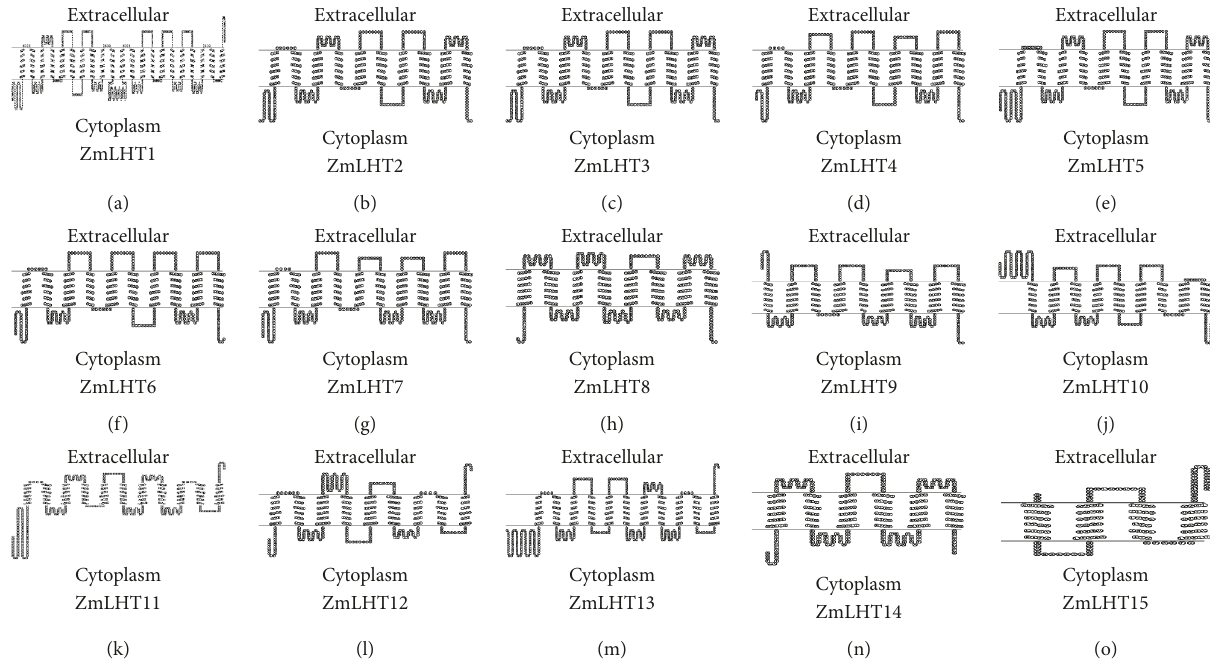
Figure 5: Analysis of transmembrane topology of LHT gene family in